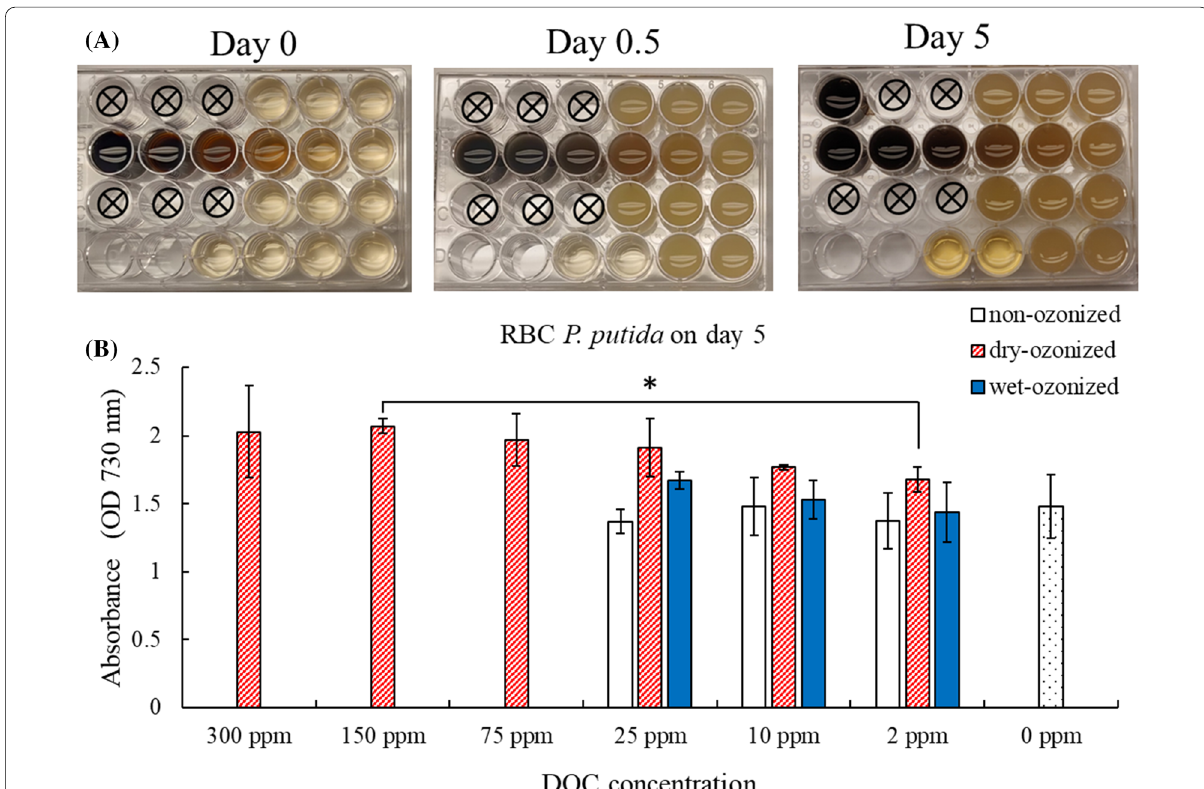
Fig. 3 Growth assay of P. putida in incubation with filtrates from wet-ozonized, dry-ozonized, and non-ozonized rogue biochar at different DOC concentrations. A Photographs of multi-well plate with RBC biochar filtrates inoculated with P. putida on day 0, day 0.5 and day 5 of the growth assay. The photographs shown are one of the two replicates. The setup of the plate is shown in Table 1. B Optical density (OD730) of P. putida after 5 days of incubation with RBC biochar filtrates. The error bars on the graph represent the standard deviation of the 2 multi-well plates ( n day 5, the P. putida inoculated in the well with 300 ppm of the dry-ozonized RBC filtrate had too much growth and OD730 could not be measured; therefore, the content of the well was split in two wells and their OD730 measurements were added. The asterisks brackets (*) show significant difference ( p < 0.05) between